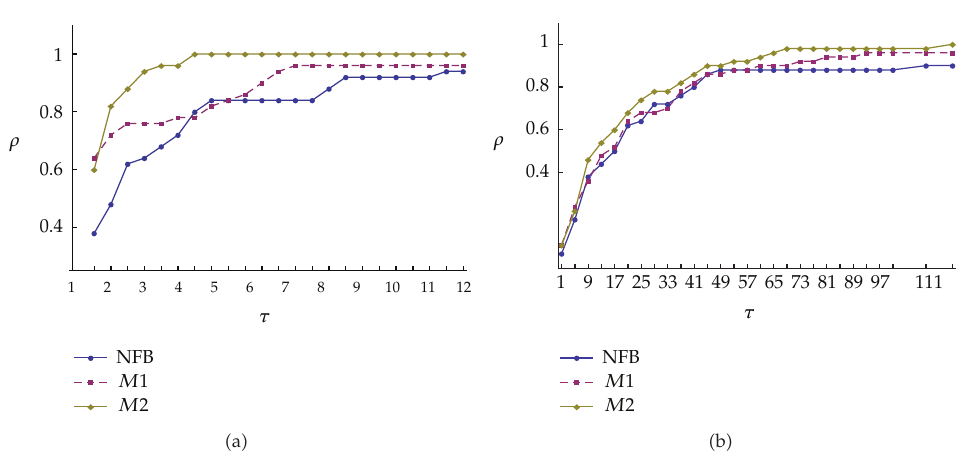
Figure 1: (cid:6) a (cid:7) Performance profile regarding the number of iterations in Table 2. (cid:6) b (cid:7) Performance profile regarding the number of iterations in Table 3.